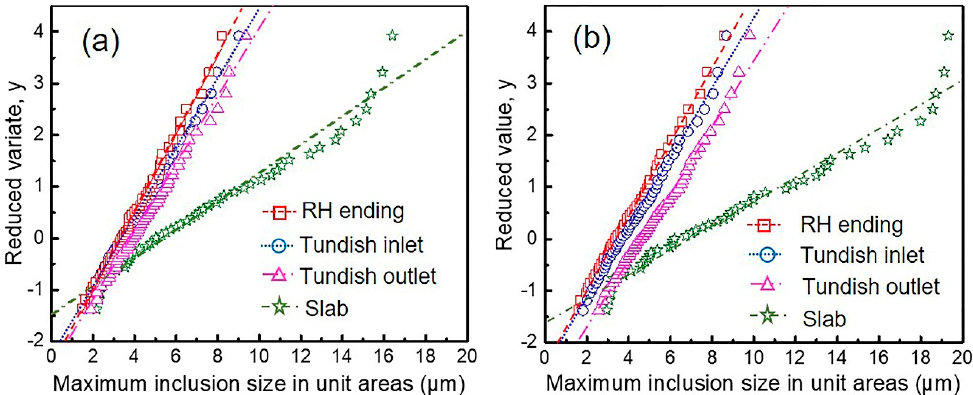
Figure 8. Comparison of EVD (Extreme Value Distribution) data at the different steelmaking stages for ( a ) Steel A and ( b ) Steel B.